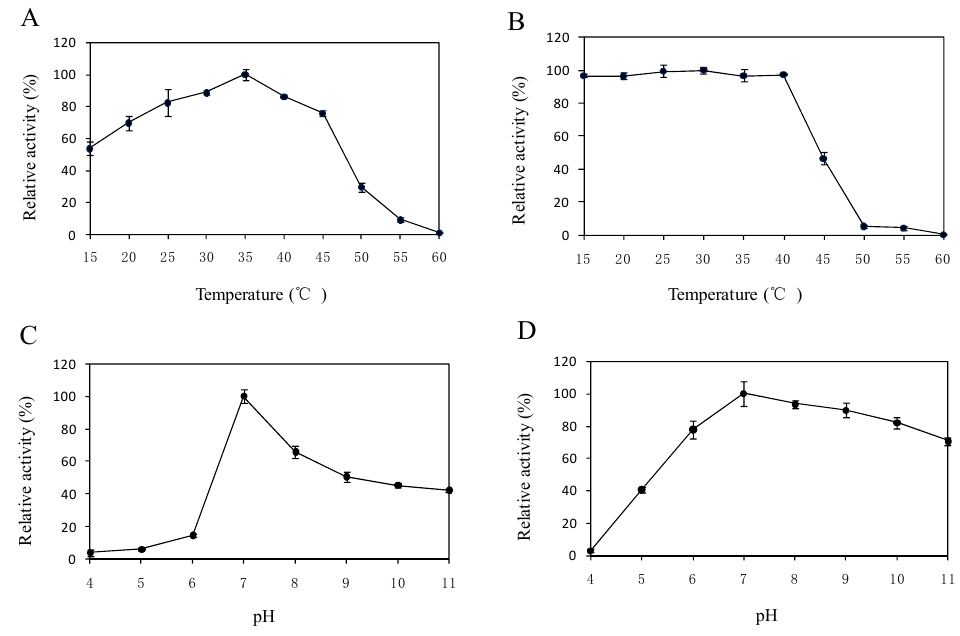
Figure 4. Effect of temperature and pH on enzyme activity of purified 001D from pET32a. ( A ) Temperature optimum; ( B ) Thermostability; ( C ) pH optimum; and ( D ) pH stability. In each case, the highest activity was set at 100%. Each treatment was done in triplicate.